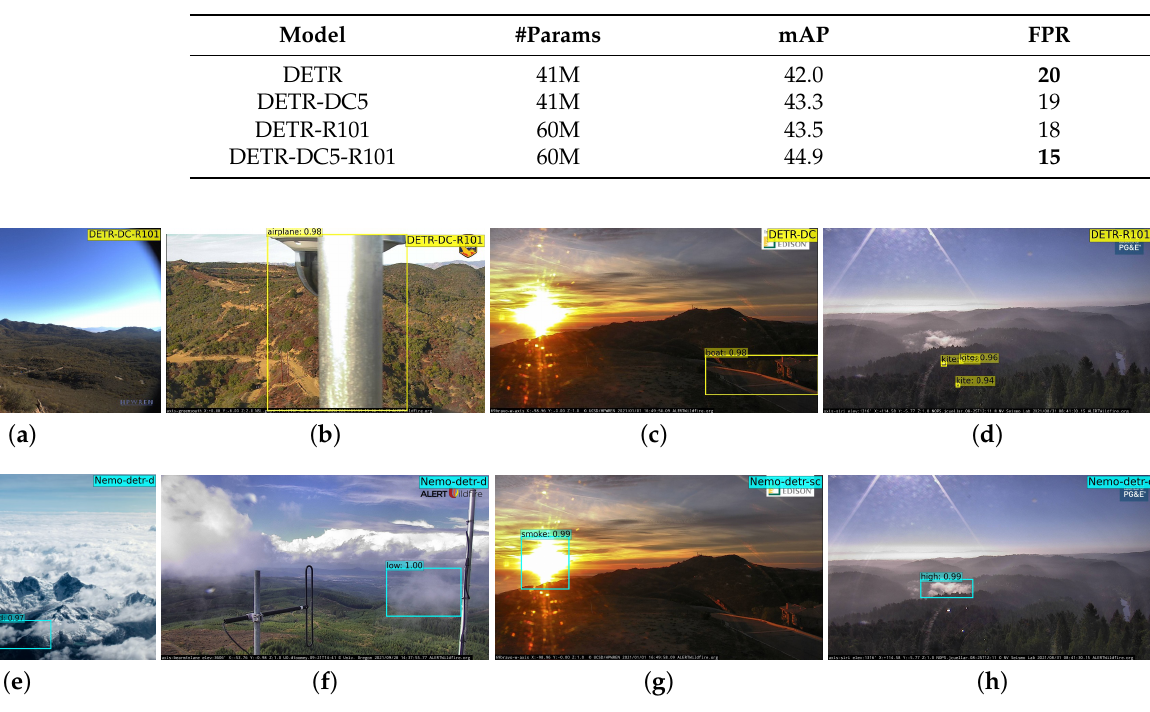
Figure 9. Images on the top show false alarm examples of the DETR COCO detector on our chal- lenging non-object test set. Images at the bottom show the same, but for the Nemo-DETR models presented in Table 3. ( a ) A tall tree is detected as a giraffe. ( b ) A camera attached to a pole is detected as an airplane with 99% confidence. ( c ) A driveway is detected as a boat. ( d ) Glares are detected as kites with high confidence. ( e ) Cloud in an unrealistic background detected as medium density smoke. ( f ) Rainy cloud detected as smoke. ( g ) Sun is detected as smoke, based on the similarity to flame, which is an object that exists near smoke in some training images. ( h ) Fog is detected as high-density